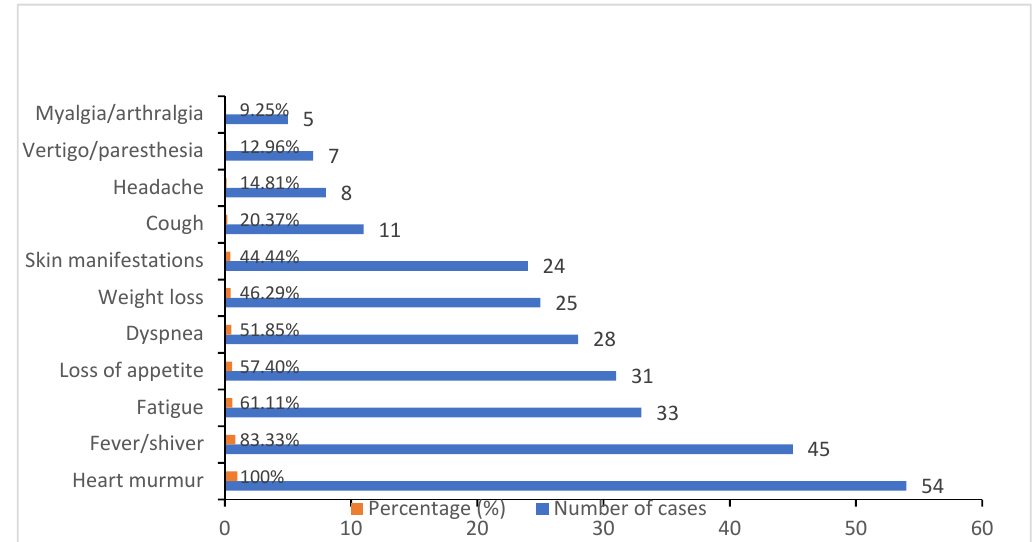
Figure 1. Prevalence of clinical manifestations at the time of hospital admission illustrated by percentages and the corresponding number of cases.